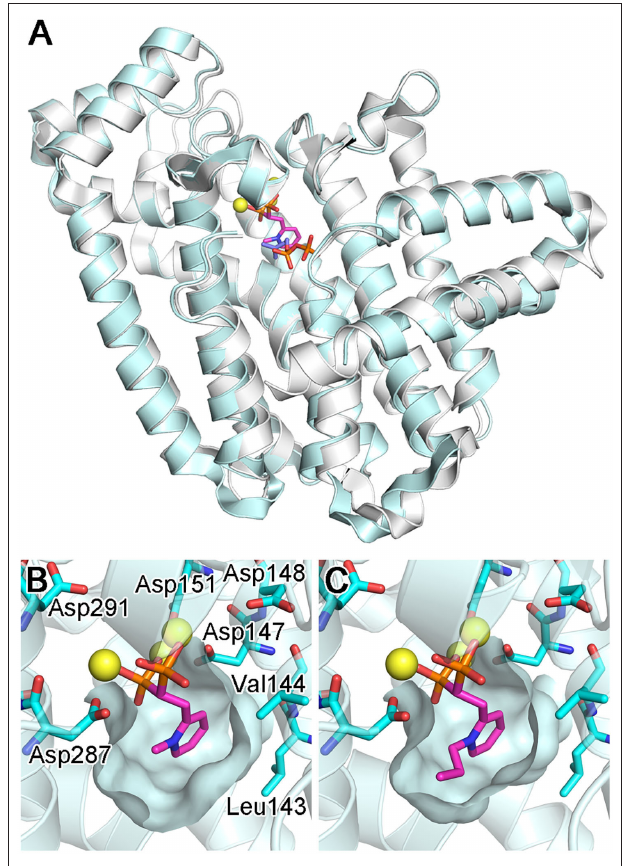
FIGURE 14 | Structures of bisphosphonate-bound Cf FPPS2. (A) The overall structure of the Cf FPPS2- 15b -IPP ternary complex (cyan; PDB ID: 6B06). Superposed in white is the structure of a human FPPS ternary complex (PDB ID: 4H5E). (B) The binding of inhibitor 15b . The structure is of the Cf FPPS2- 15b binary complex (PDB ID: 6B04). (C) The binding of inhibitor 15d (PDB ID: 6B07). Displayed residues are identical as in (B) .